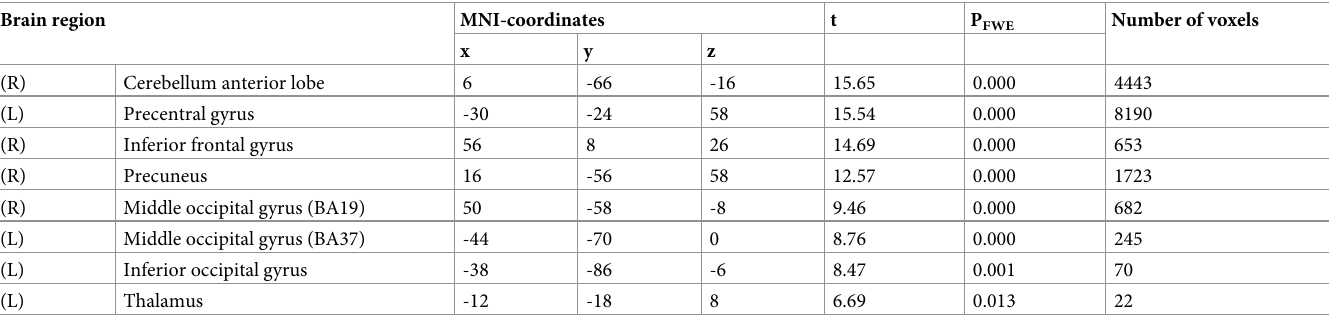
Table 3. Brain activation for refinement (B2) versus preliminary ideas (B1). Brain